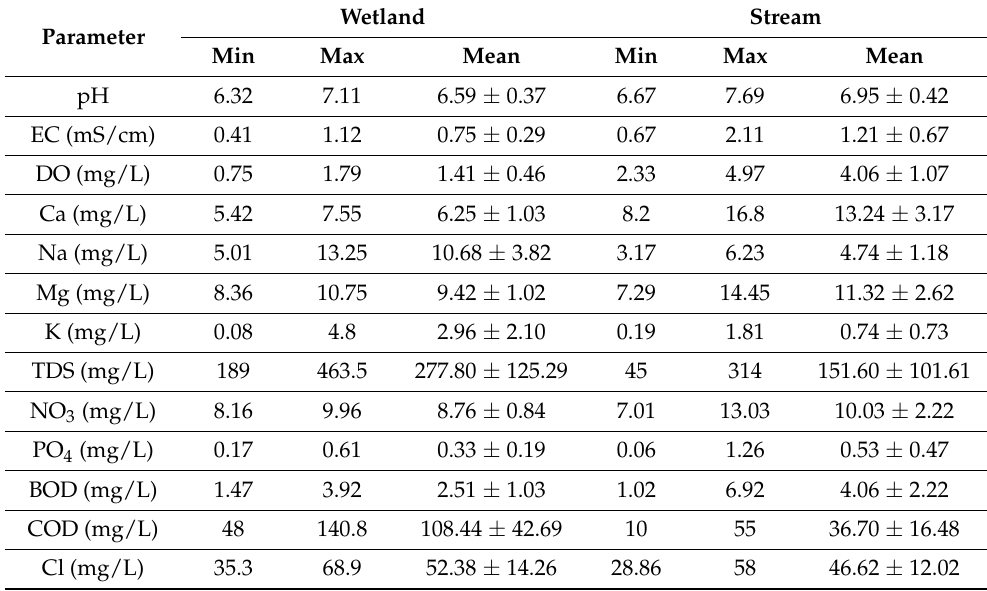
Table 1. Physicochemical and nutrient parameters of stream and wetland water (Mean ± Standard Deviation). Wetland Parameter